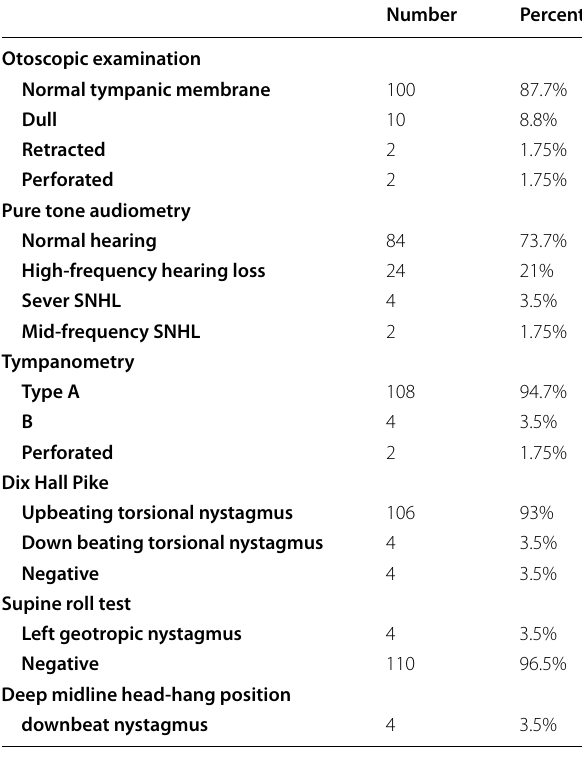
Table 1 Clinical features of the patients